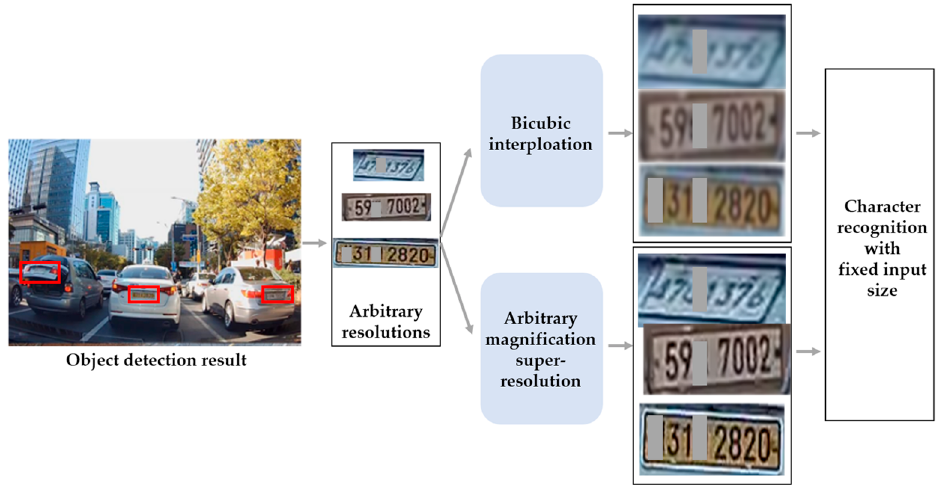
Figure 5. Example application of arbitrary magnification super-resolution in license plate character recognition task. One or two characters were masked due to privacy policies.